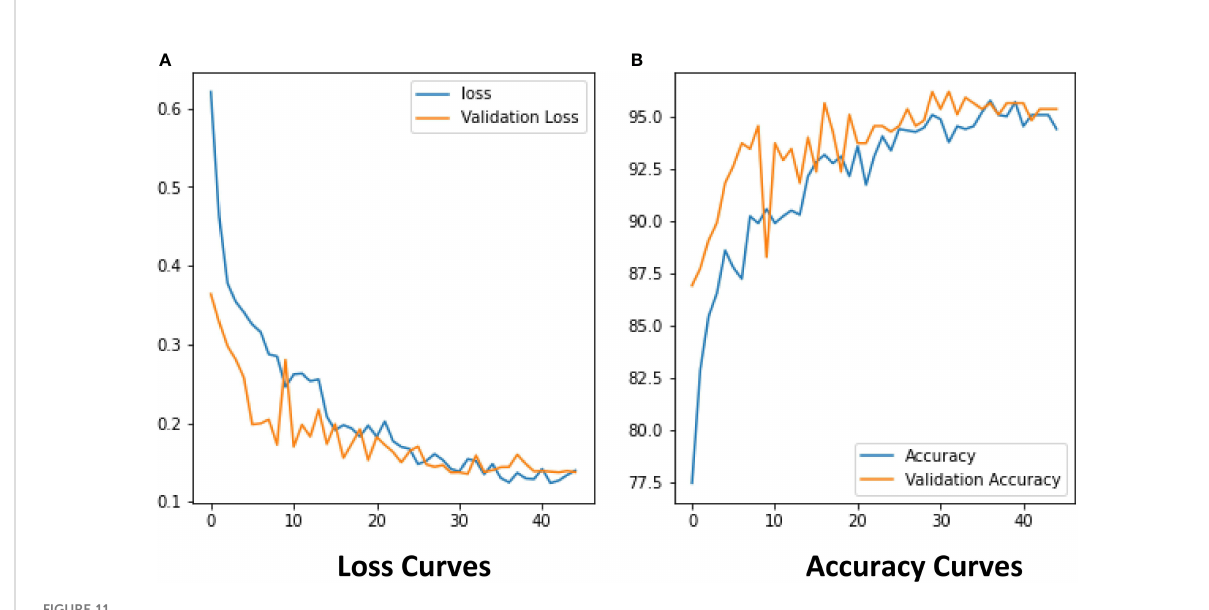
FIGURE 11 The Loss and Accuracy of classi fi cation model. (A) Loss Curves, (B) Accuracy Curves.